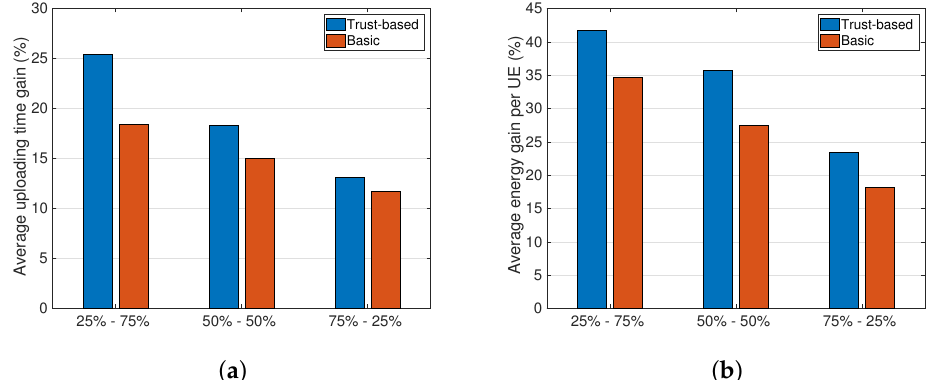
Figure 2. Impact of type A and type B malicious nodes (feasility threshold, FT = 0.5). ( a ) Uploading time gain; ( b ) Average energy